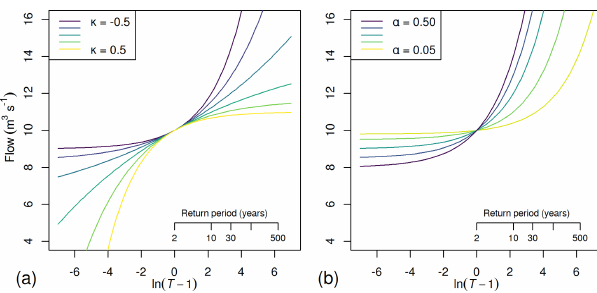
Figure 2. Example GLO flood frequency curves. (a) Varying κ , with α = 0 . 5, ξ = 10; (b) varying α with κ = 0 . 5, ξ = 10. Plotted on logistic reduced variate